Question: Briefly state, in one sentence, what is plotted here.
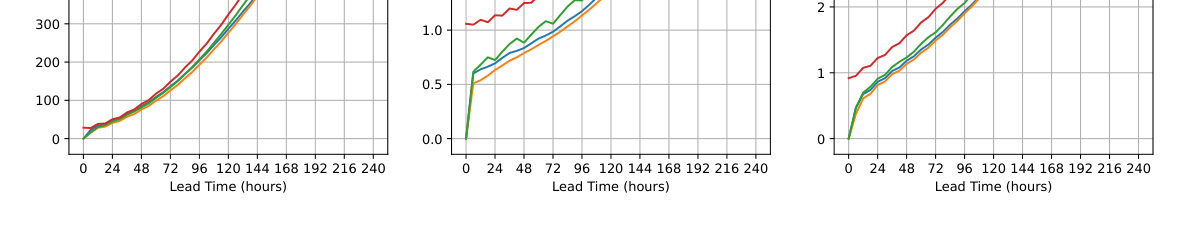
Answer: Weatherbench 2 deterministic RMSE comparison of forecasts of z500, t2m, and u10m at lead times up to 10 days for the swin model using channel-weighting, 8-step fine-tuning, and latitude-weighted loss, IFS HRES, Pangu-Weather, and Graphcast compared to climatology.